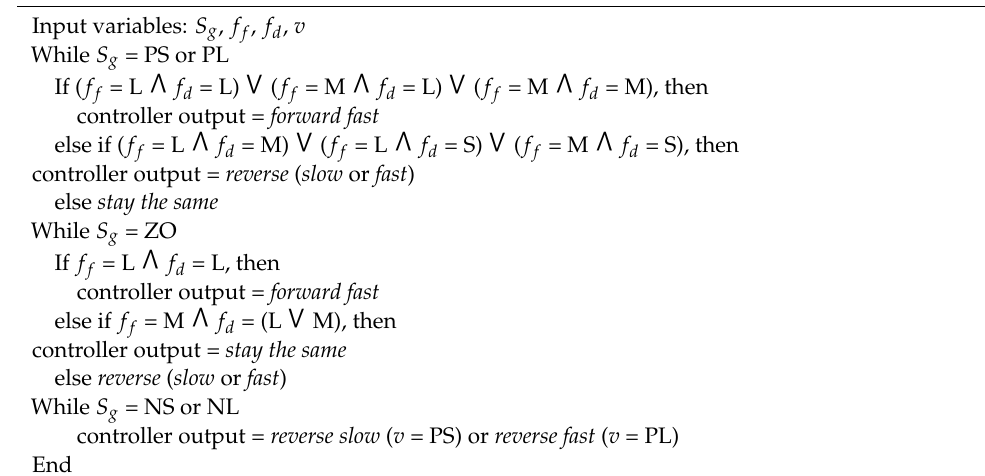
Algorithm 2: Power assistance design user’s posture ( v = PS or PL)